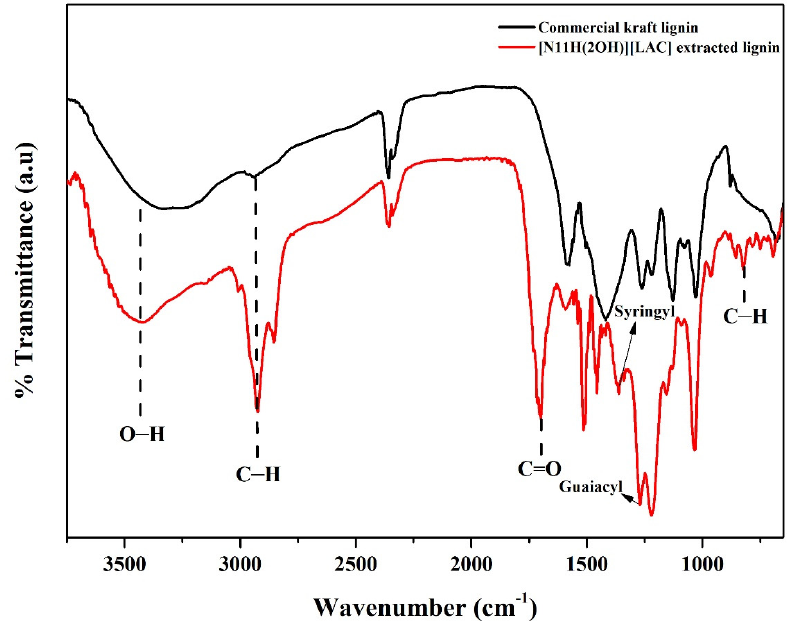
Figure 4. ATR-FT-IR spectra for the fingerprint regions of lignin extracted from pine wood biomass using [N11H(2OH)][LAC] pretreatment.